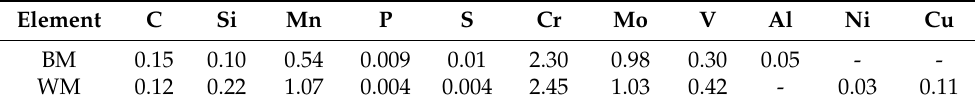
Table 2. Chemical composition of base metal (BM) and weld metal (WM) (wt.%). Element C Si Mn